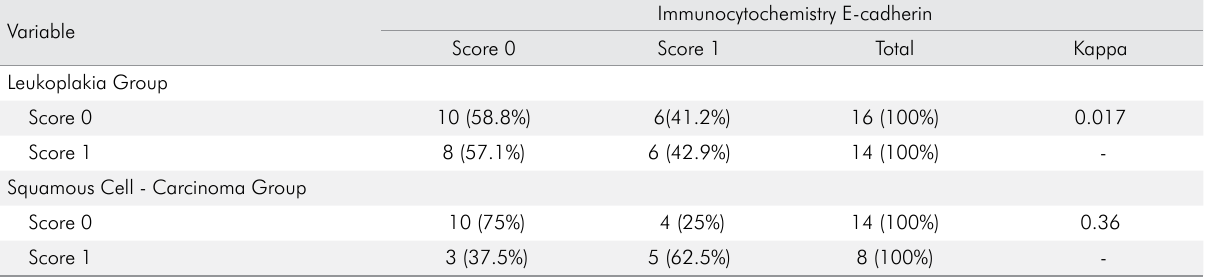
Table 2. Level of agreement between immunocytochemical and immunohistochemical expression of E-cadherin in the leukoplakia and squamous cell carcinoma